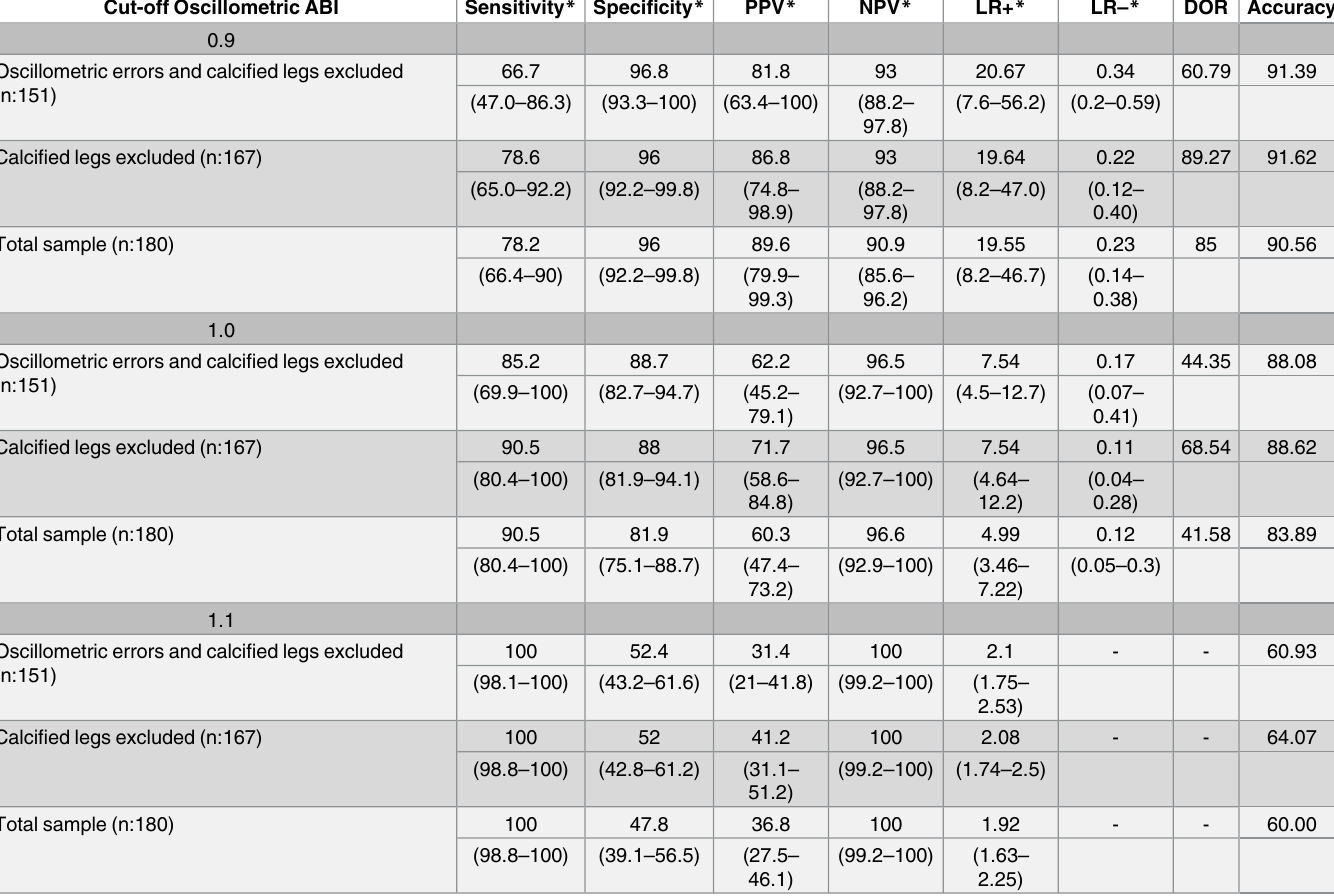
Table 3. Diagnostic performance of oscillometric ABI in the detection of PAD compared with Doppler ABI. Cut-off Oscillometric ABI Sensitivity * Specificity * PPV * NPV * LR+ * LR– * DOR Accuracy